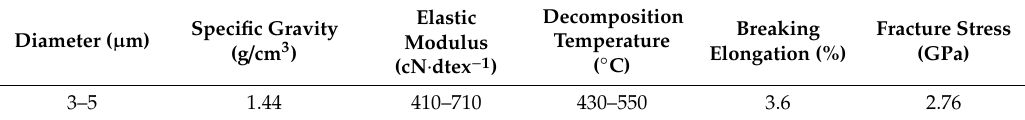
Table 4. Characteristics of aramid